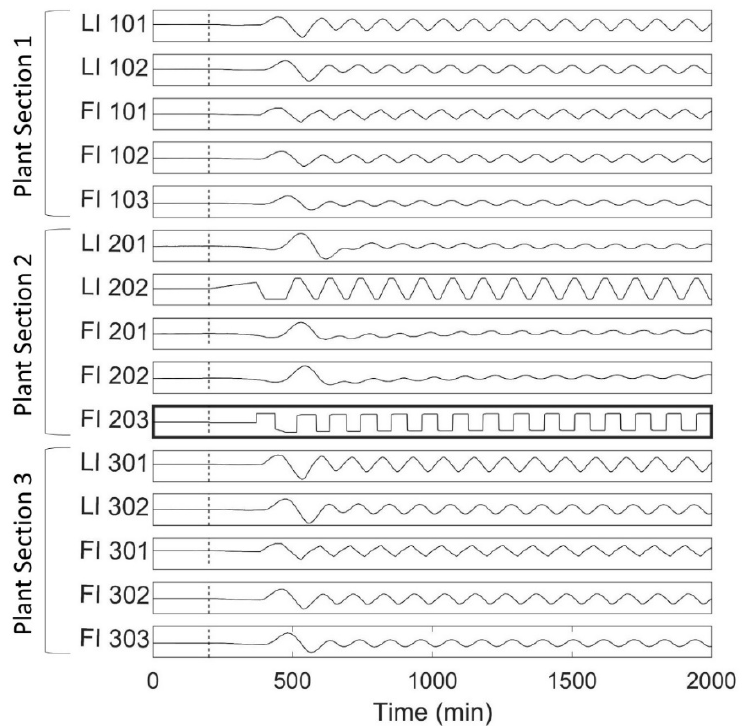
Figure 3. Time series data generated using tank network simulation with and without valve stiction online FI 203 (indicated with a bold border). The vertical dashed line indicates the beginning of the valve stiction. PSs are indicated by open brackets on the left-hand side and the first number in each tag name indicates its PS. LI, level indicator; FI, flow indicator.